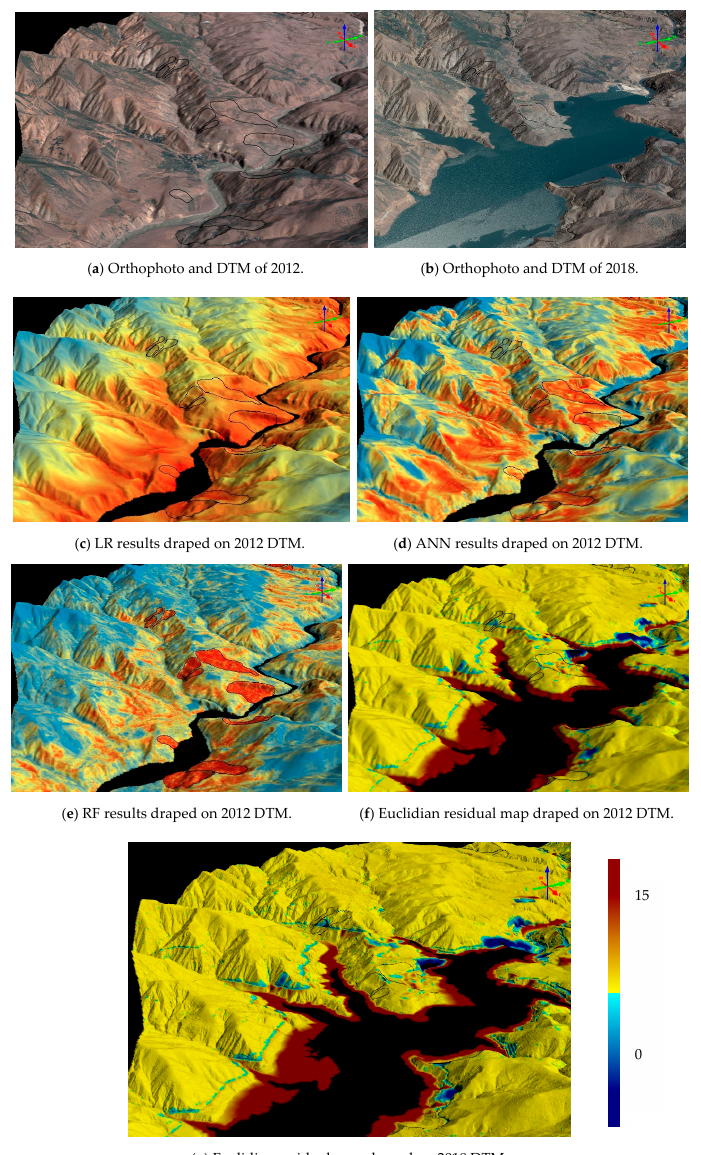
( g ) Euclidian residual map draped on 2018 DTM. Figure 14. The ortophotos ( a , b ), ML outputs ( c – e ), and plots of the Euclidian differences ( f – g ) obtained from the comparison between 2012 and 2018 DTMs of the study area. Dam construction area is shown here.